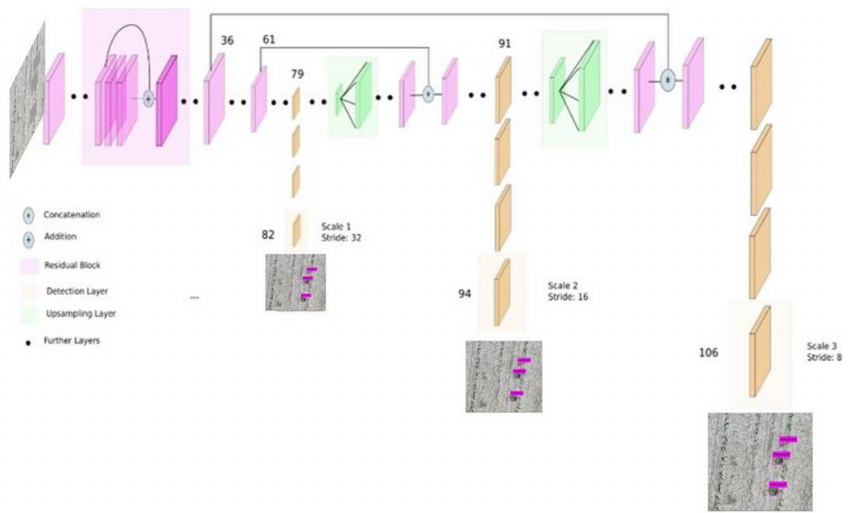
Figure 3. YOLOv3 network architecture—detection at three different scales are combined for the final detection (Figure adapted from